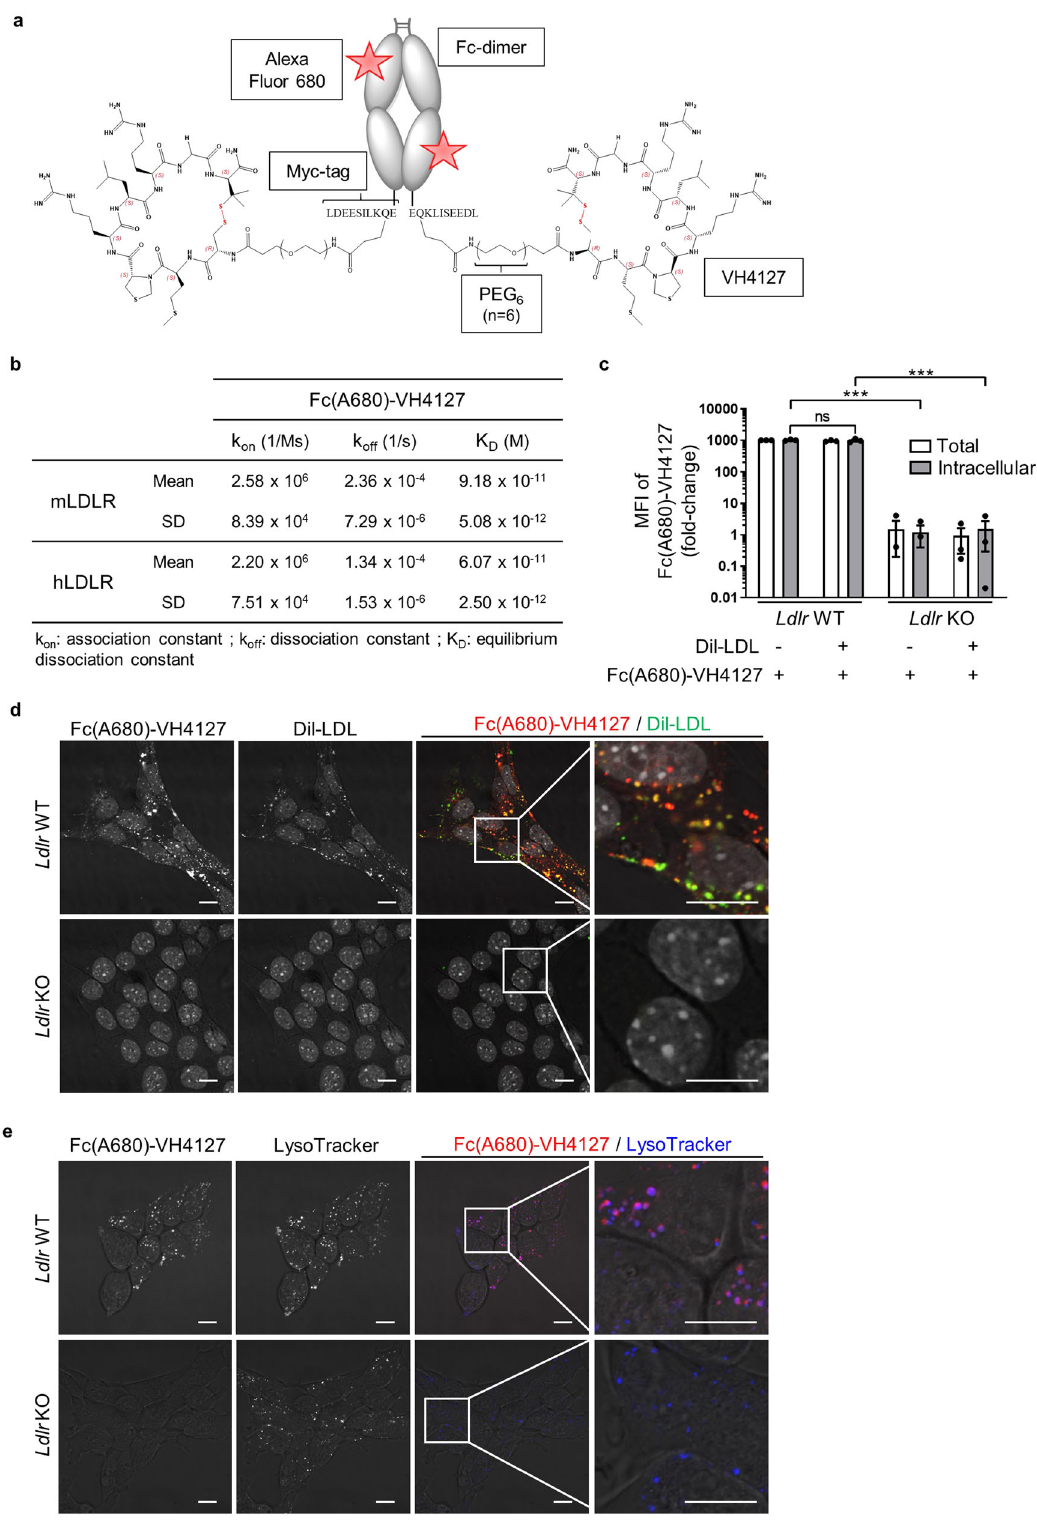
taken up by cells just as the natural ligand, in a LDLR- dependent manner, and was ef fi ciently delivered to the late endosome/lysosome compartment, as shown by its co- localization with lysotracker (Fig. 3d, e vs Supplementary Fig. 3d,